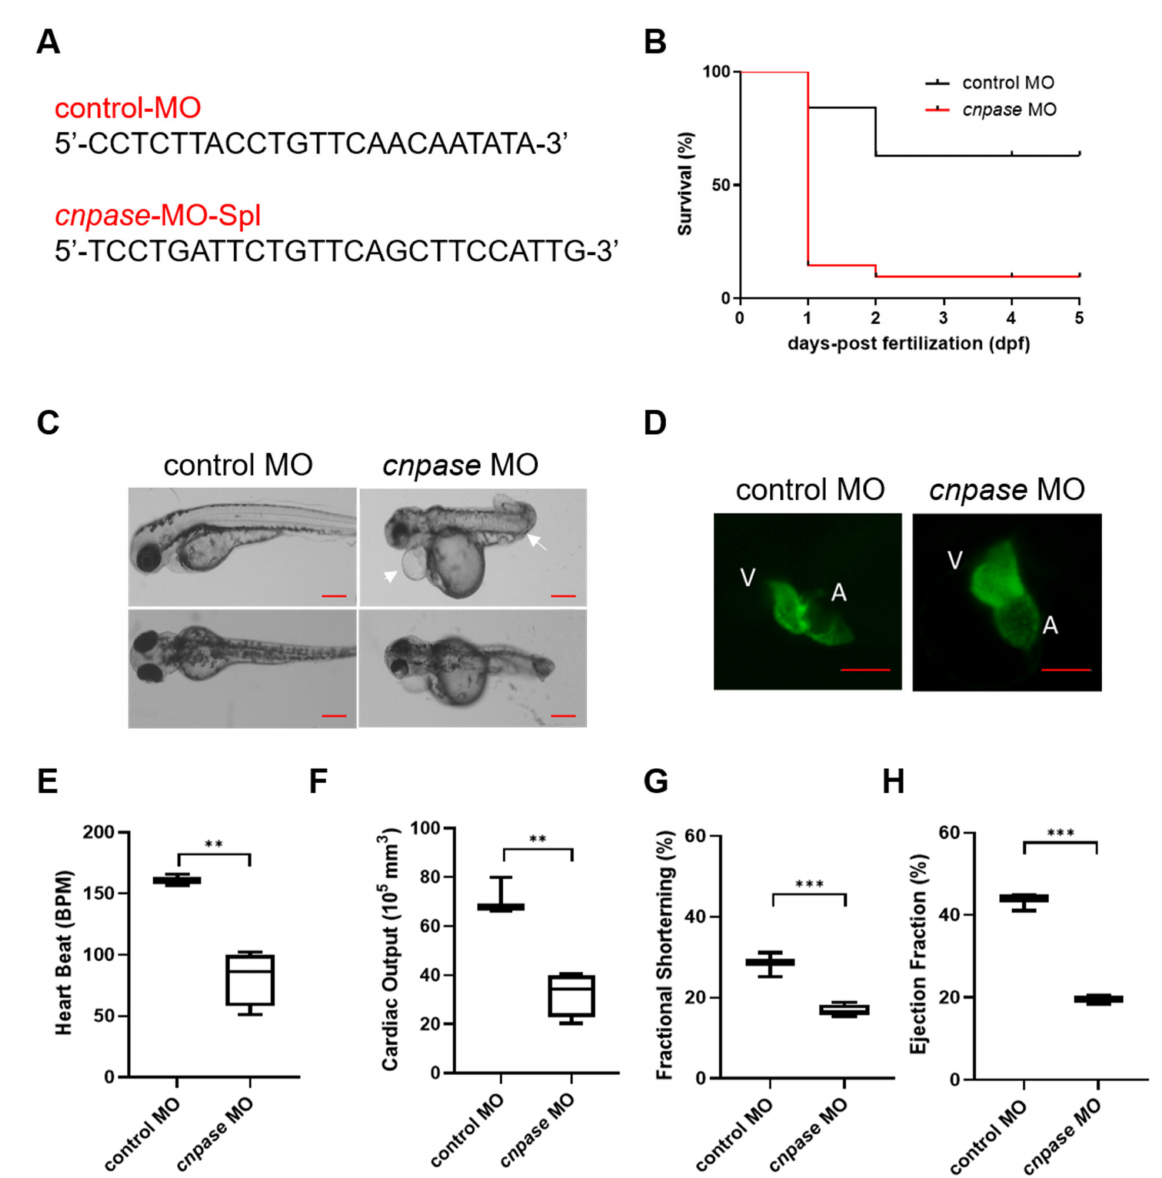
Figure 1. Morpholino-mediated cnpase knockdown results in a heart failure phenotype in zebrafish larvae. ( A ) The target sequences of control morpholino and morpholino targeting cnpase . ( B ) Effects of morpholino injection on the survival rate of zebrafish embryos over 120 hpf, n = 25~50. hpf, hours post-fertilization. ( C ) Phenotypes of the tg( myl7:gfp ) zebrafish after cnpase -MO administration at 4 dpf. Arrows indicate the pericardial edema and malformation of body shape. dpf, days post-fertilization. Scale bar, 1000 µ m. ( D ) cnpase-morpholino administration results in enlarged ventricular and atrium size. The images were captured by upright fluorescence microscope (Axio Imager A2, Zeiss). Scale bar, 1000 µ m. ( E – H ) Cardiac function evaluation of zebrafish embryo after MO injection at 4 dpf, n = 25~50. Values are expressed as mean ± SD. Unpaired t-test, **, p < 0.005; ***, p <